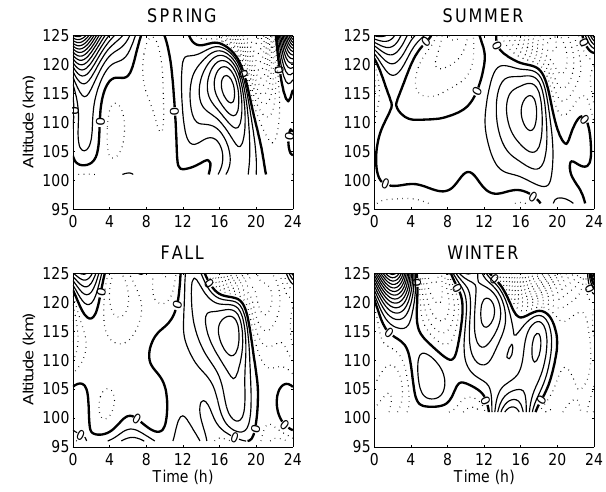
Fig. 5. Vertical velocity field in the presence of both wind and elec- tric field for spring, summer, fall and winter; the same plot details as in the previous figures.